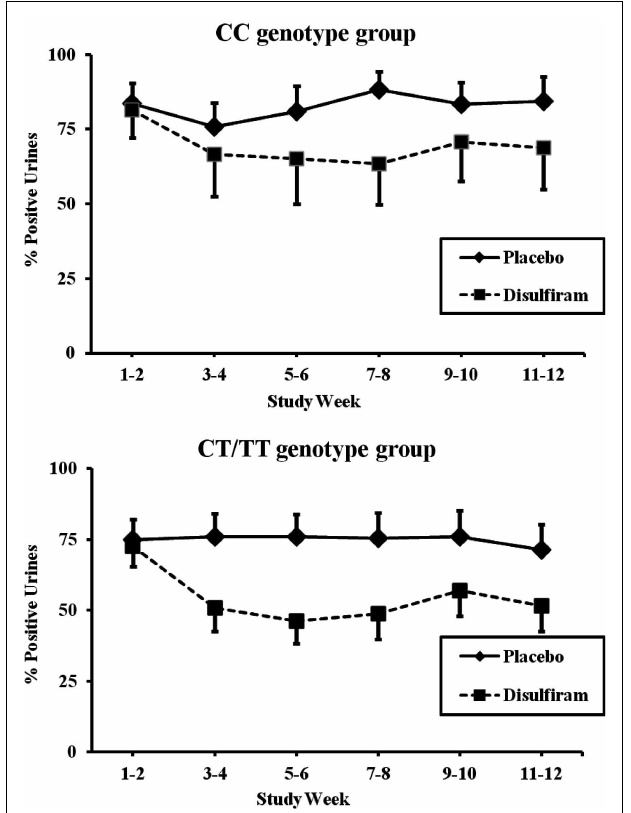
FIGURE 3 | Response of MTHFR C677T CC and CT/TT genotype groups to disulfiram pharmacotherapy in individuals with complete urine toxicology data ( N = 56). Cocaine-positive urine toxicologies are shown for each 2week time period across the 12-week trial in percent positive urines.The solid line represents time points for the placebo treatment group and the dashed line represents time points for the disulfiram treatment group (250mg/day).Top panel: patients with the MTHFR CT/TT orTT genotype (disulfiram, N = 14; placebo, N = 18). Bottom panel: patients with MTHFR CC genotype (disulfiram, N = 10; placebo, N = 14). Standard error bars are shown for each time